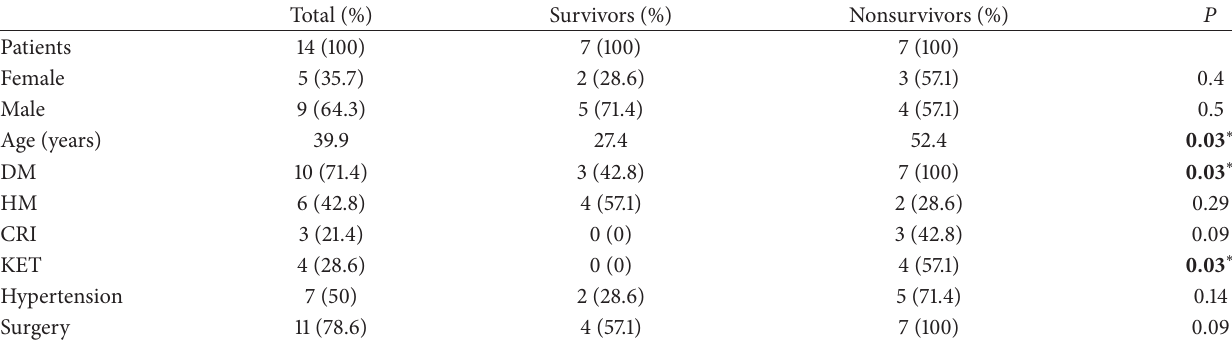
Table 1: Demographic data.